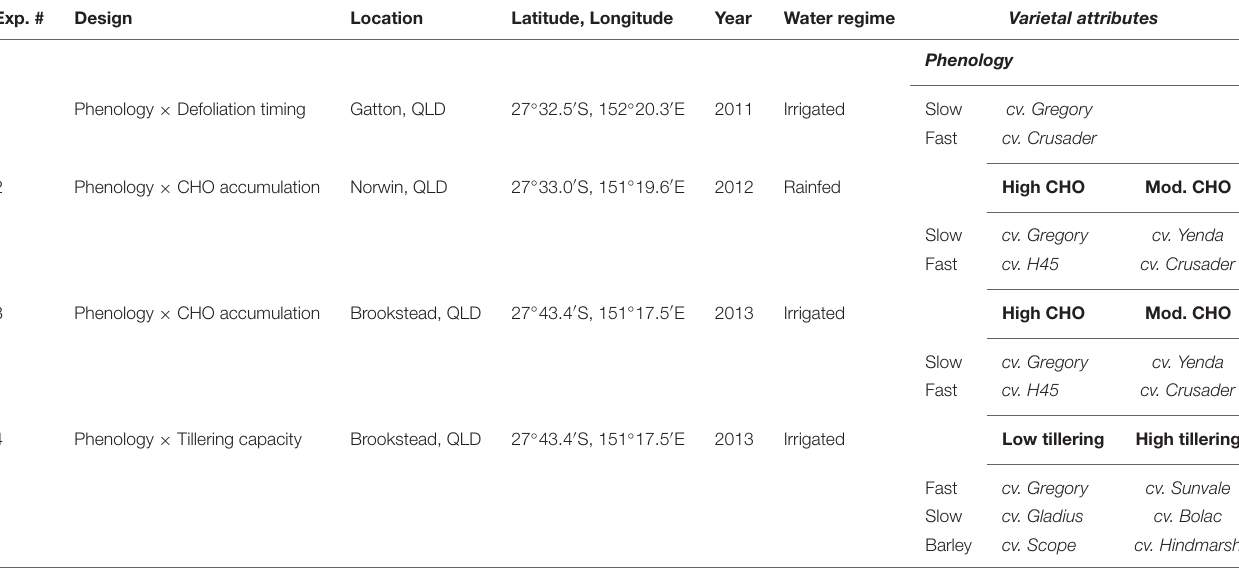
TABLE 1 | Experimental design, locations, and cultivars used to compare phenology (fast vs . slow), soluble carbohydrate accumulation (CHO) and tillering capacity related to response after defoliation in spring wheats. Exp.